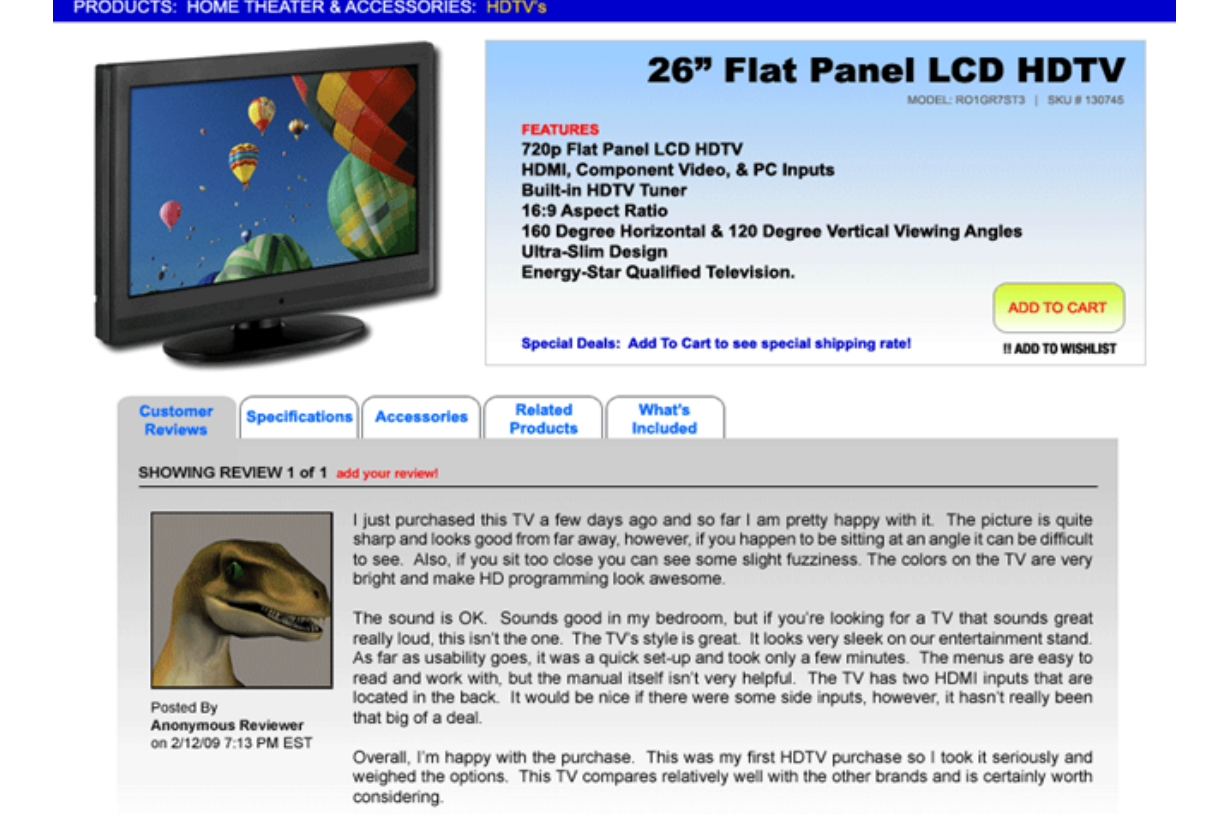
Low credibility and low anthropomorphic image, high credibility